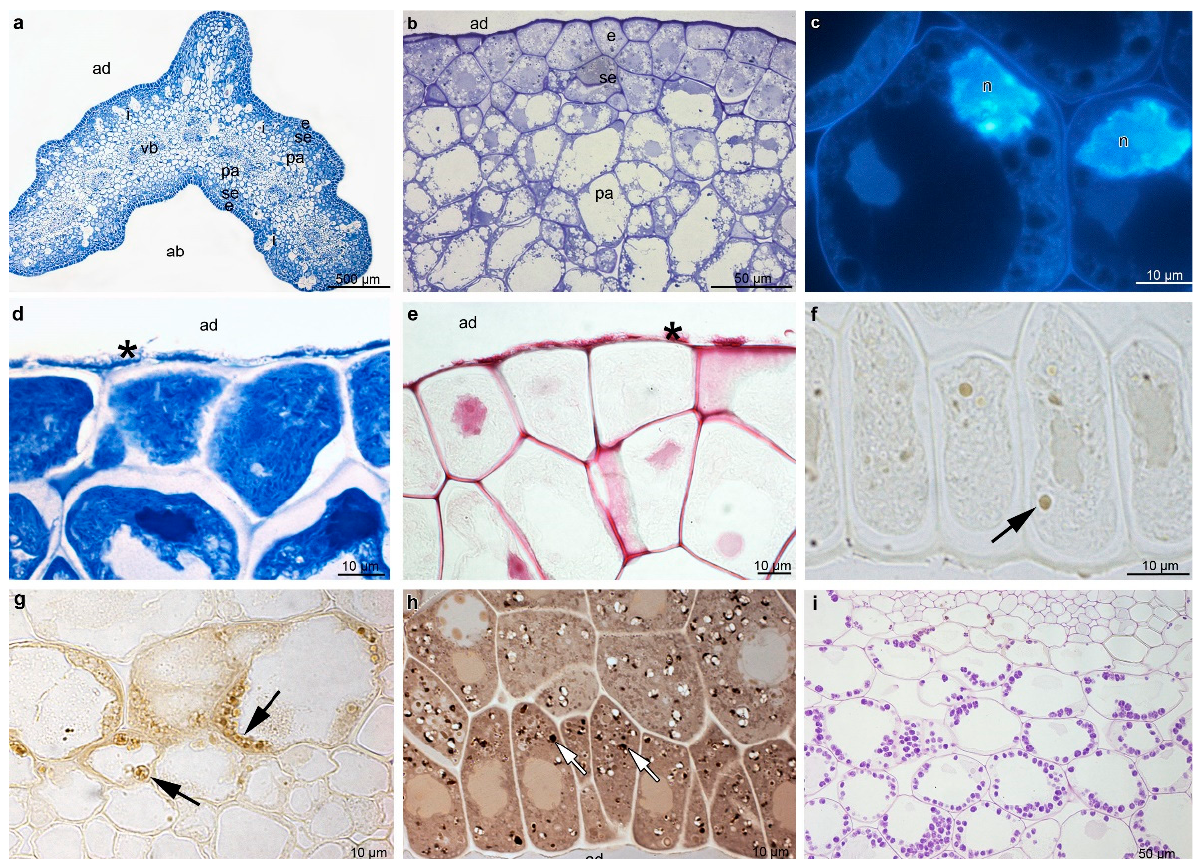
Figure 3. Histochemical features of the B. carunculatum (transverse sections). ( a ) General view (stained with ABB) showing a single layer of the epidermis, a few layers of sub-epidermal cells with idioblasts, and several collateral vascular bundles in the ground parenchyma. ( b ) Detail of the adaxial surface of the middle lobe, with dense cytoplasm and enlarged nuclei in the epidermis and sub-epidermis (TBO). ( c ) Enlarged nuclei in the adaxial sub-epidermis (DAPI). ( d ) The epidermis and sub-epidermal tissue stained intensively for proteins (ABB), note the secretory material on the surface (black asterisk). ( e ) I Staining with ruthenium red revealed the presence of mucilage (black asterisk) on the adaxial epidermis of the middle lobe. ( f , g ) Dihydroxyphenols inclusions (FeCl 3 ) in the cytoplasm (possibly plastids) of epidermal cells ( f ) and in singular cells near the vascular bundle ( g ) (black arrows). ( h ) Lipid droplets (white arrows) in the adaxial epidermis and sub-epidermis. ( i ) Abundance of starch grains in the ground parenchyma (PAS). ab: Abaxial surface, ad: adaxial sur-